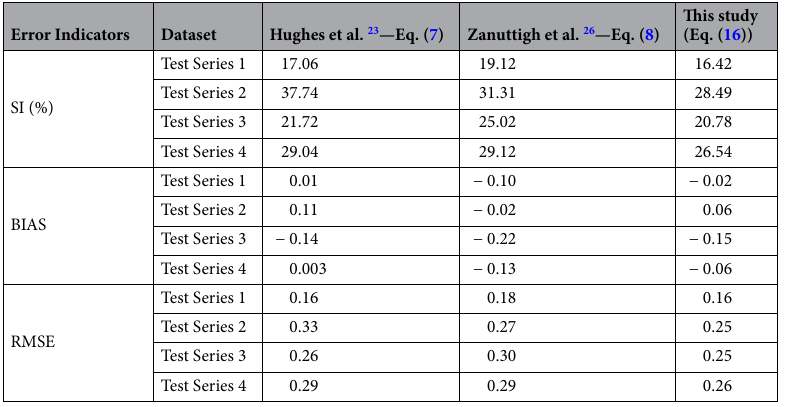
Table 2. Summary of the statistical indicators for empirical formulae in predicting Weibull b values at plain vertical walls under impulsive conditions.